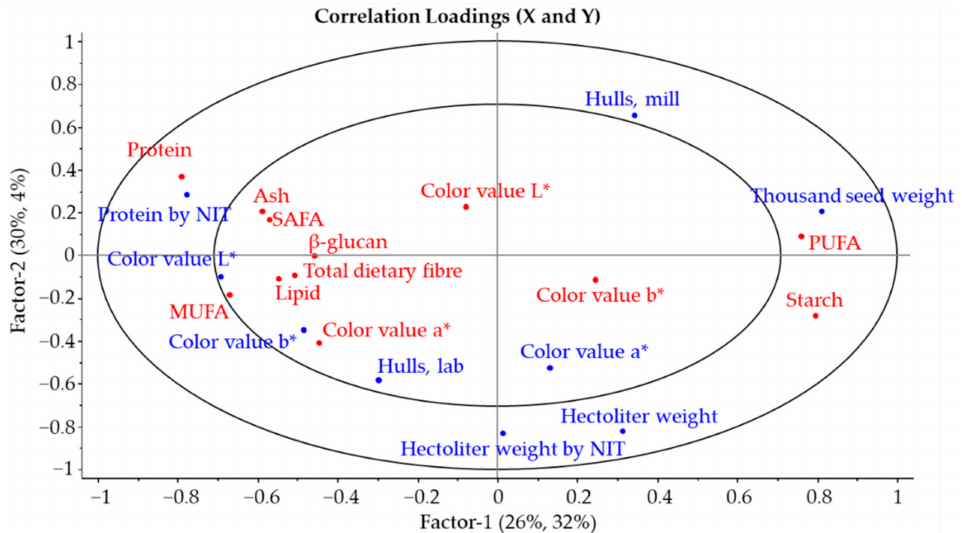
Figure 2. Partial least squares (PLS) regression projection of factors 1 and 2 of the native oat grain (blue) and heated oat flour (red) properties. The color values are L*, a* and b*; NIT, near-infrared trans- mittance; SAFA, saturated fatty acids; MUFA, monounsaturated fatty acids; PUFA, polyunsaturated fatty